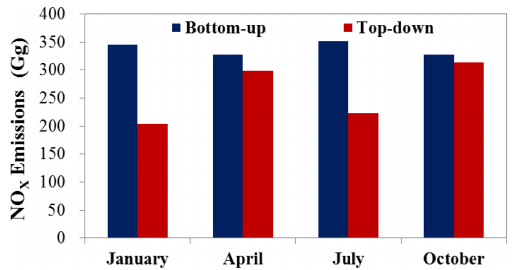
Figure 2. The bottom-up and top-down estimates of NO x emissions by month for the YRD region in